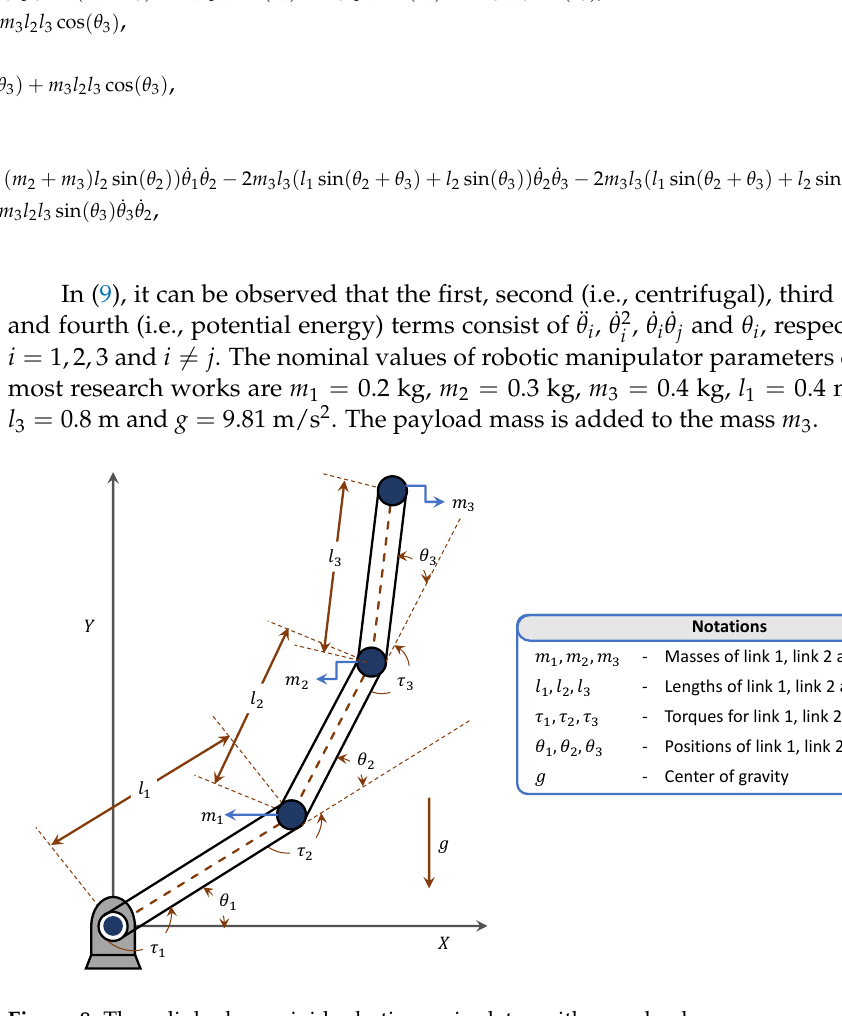
Figure 8. Three-link planar rigid robotic manipulator with a